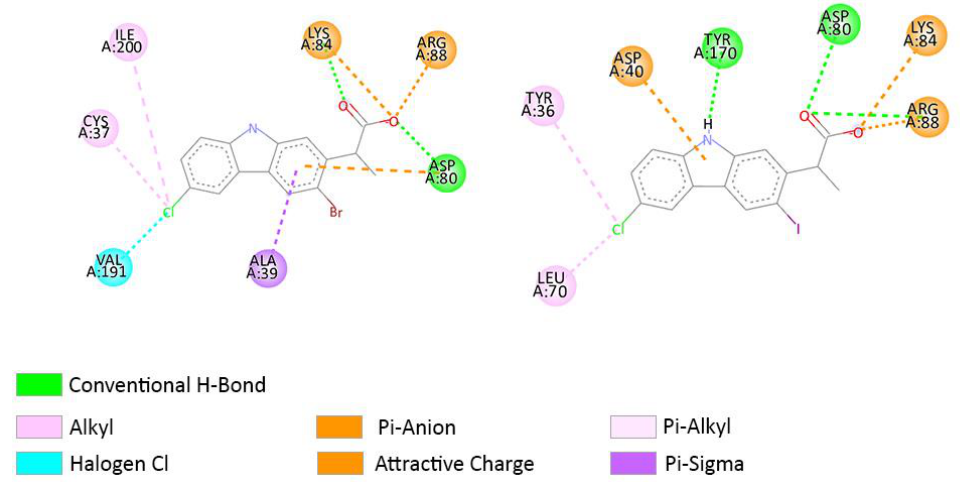
Figure 13. Predicted interactions between compounds 2 ( left ) and 3 ( right ) in interaction with TyrRS. Images were obtained using Discovery Studio Visualizer [33].